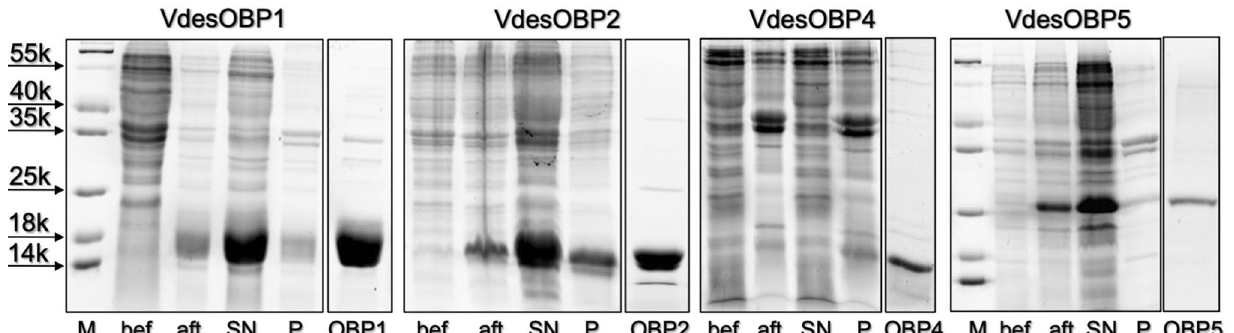
Figure 2. Expression and purification of four OBPs of V. destructor . While VdesOBP1, VdesOBP2 and VdesOBP5 were easily produced in bacteria, VdesOBP3 and VdesOBP4, which are structurally related, proved difficult to express. In fact, VdesOBP4 was obtained only in very low yield, while we could not observe expression of VdesOBP3 in any of the different constructs adopted. M: Molecular weight markers; bef: crude sample before culture induction; aft: crude sample after induction with IPTG; SN: supernatant after lysis and centrifugation; P: pellet after lysis and centrifugation; OBP: sample of purified VdesOBP5 were subjected to extensive alkylation with iodoacetamide under non-reducing denaturing condi- tions; after purification, they were then digested with trypsin followed by a second treatment with chymot-